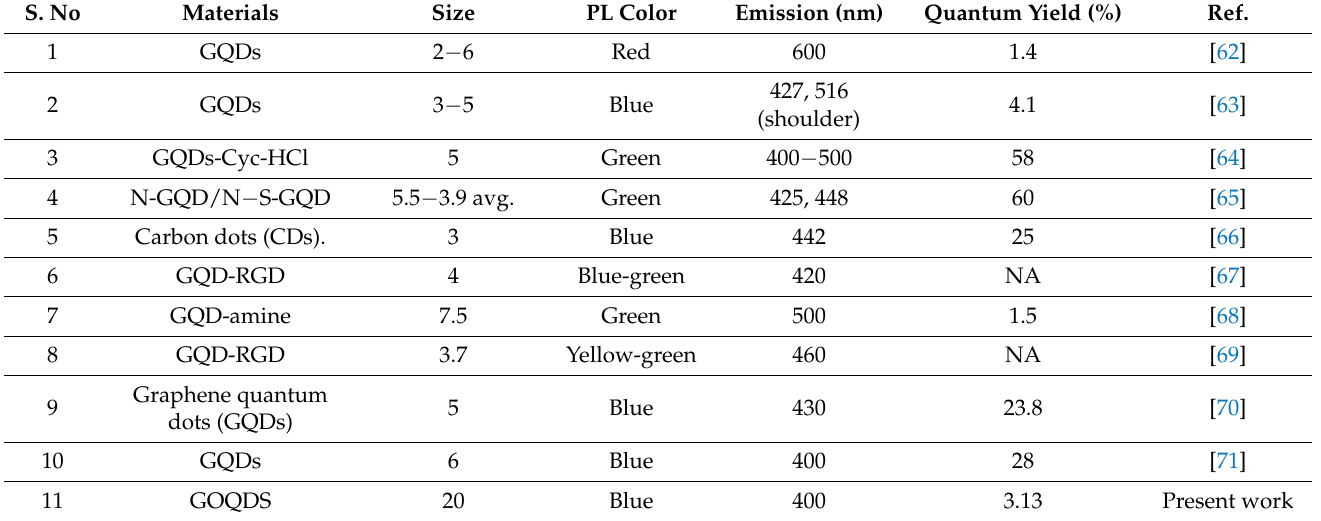
Figure 4. ( a ) UV − Vis absorption, fluorescence excitation and emission spectra of the green syn- thesized GOQDs. The arrows indicate the direction towards the respective ax (absorption or FL). ( b ) Corresponding fluorescence spectra of GOQDs with variable intensities at different excitation wavelengths ranging from 260 nm to 440 nm. Table 2. Physical parameters of synthesized